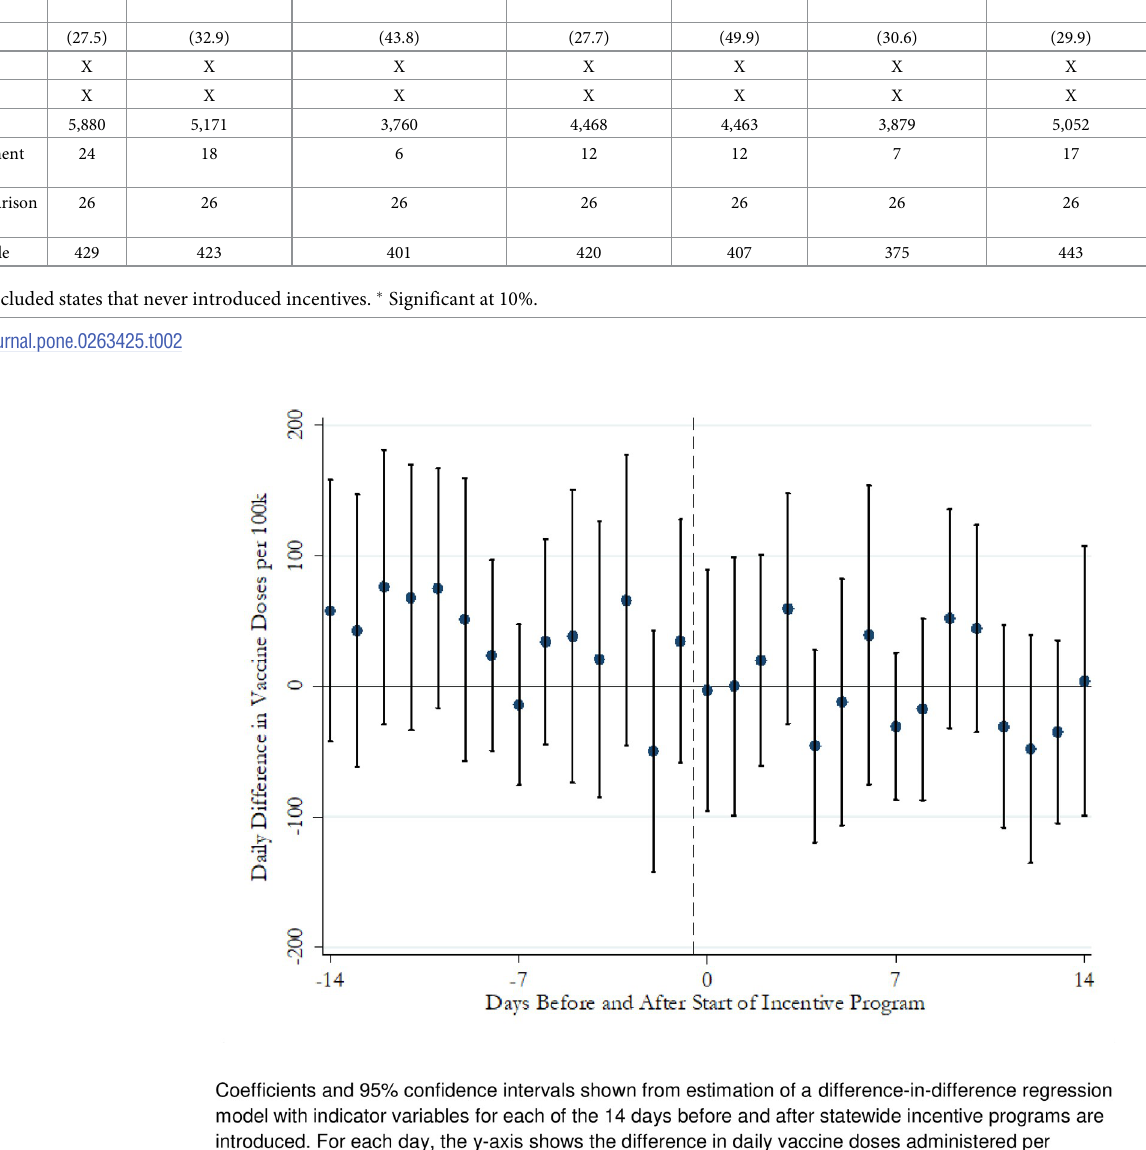
Fig 1. Difference-in-differences analysis of daily vaccination rates in states with and without incentive programs, 14 days before and after start of incentive programs. Coefficients and 95% confidence intervals shown from estimation of a difference-in-difference regression model with indicator variables for each of the 14 days before and after statewide incentive programs are introduced. For each day, the y-axis shows the difference in daily vaccine doses administered per 100,000 individuals between states with and without statewide incentive programs, after adjusting for time-invariant differences across states and for national trends with state and date fixed effects, respectively.